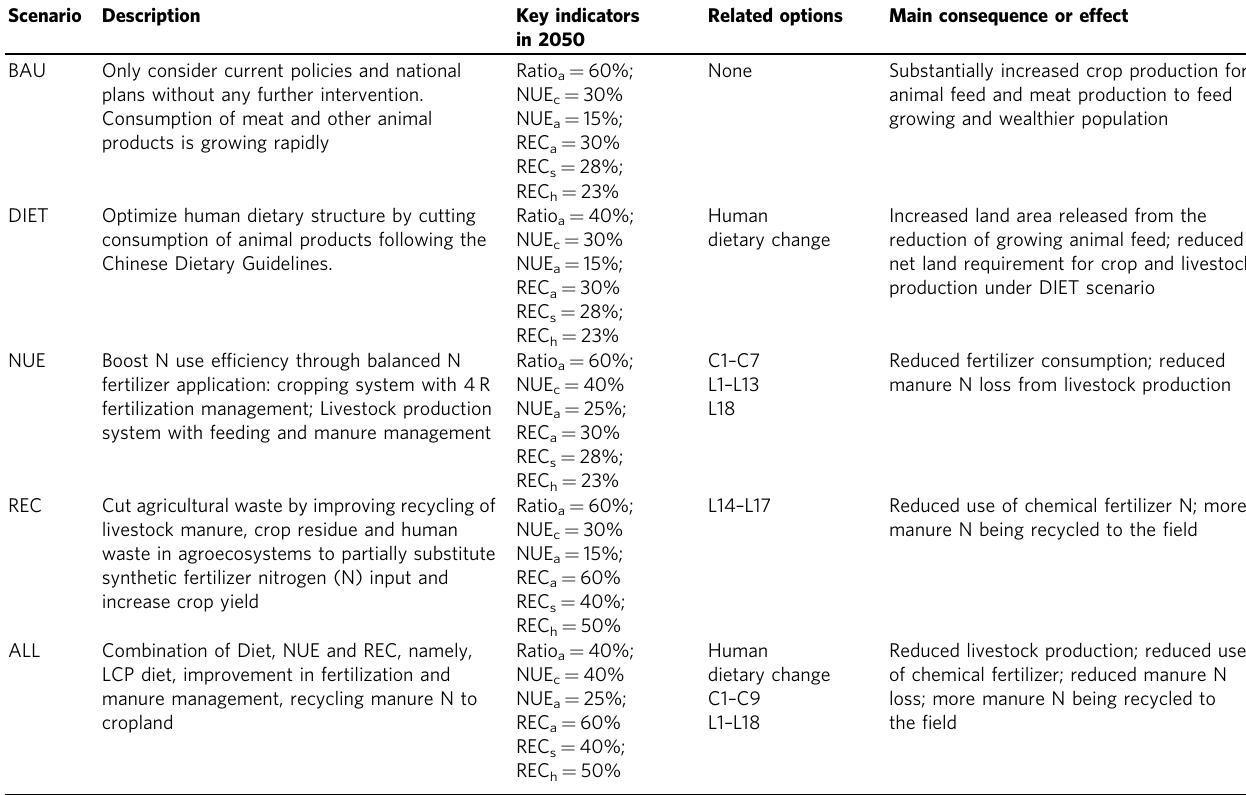
Table 3 Proposed NH 3 mitigation pathways with key indicators. Scenario Description Key indicators